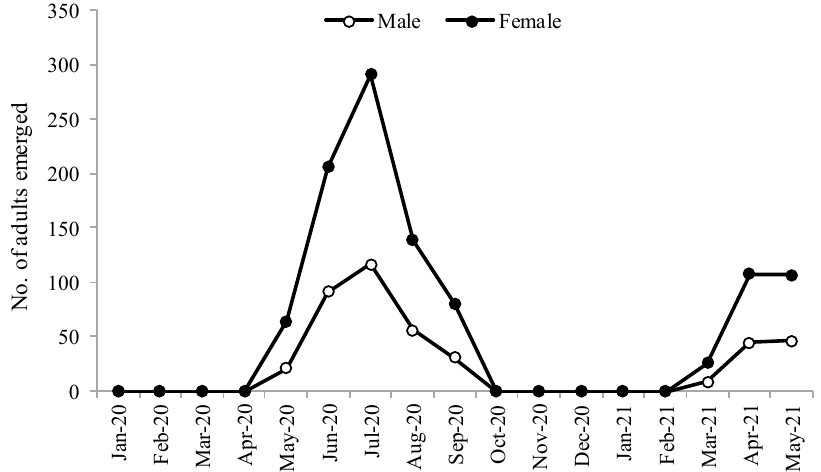
Figure 3. Emergence of male and female Megachile cephalotes from January 2020 to May 2021.